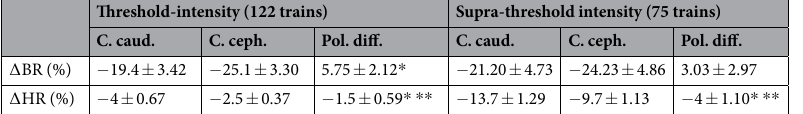
(Fig. 1e), whereas the HR response with intact vagus (Fig. 1d) disappeared after the vagotomy (Fig. 1e). In 10 animals that eventually underwent caudal vagotomy (group 2), there was an average change of − 22.4% in HR and − 39.5% in BR; after the vagotomy, the BR response remained ( − 46%), whereas the HR response disappeared ( − 0.05%) (Fig. 1f; Paired t -test, p NS top panel; p < 0.001 bottom). This indicates that VNS-elicited change in heart rate ( ∆ HR) is an index of efferent fiber activation. Stimulus polarity did not affect which afferent and effer- ent responses survived or disappeared after vagotomy. Additionally, no differences were observed between the left and right vagotomies (data not shown).